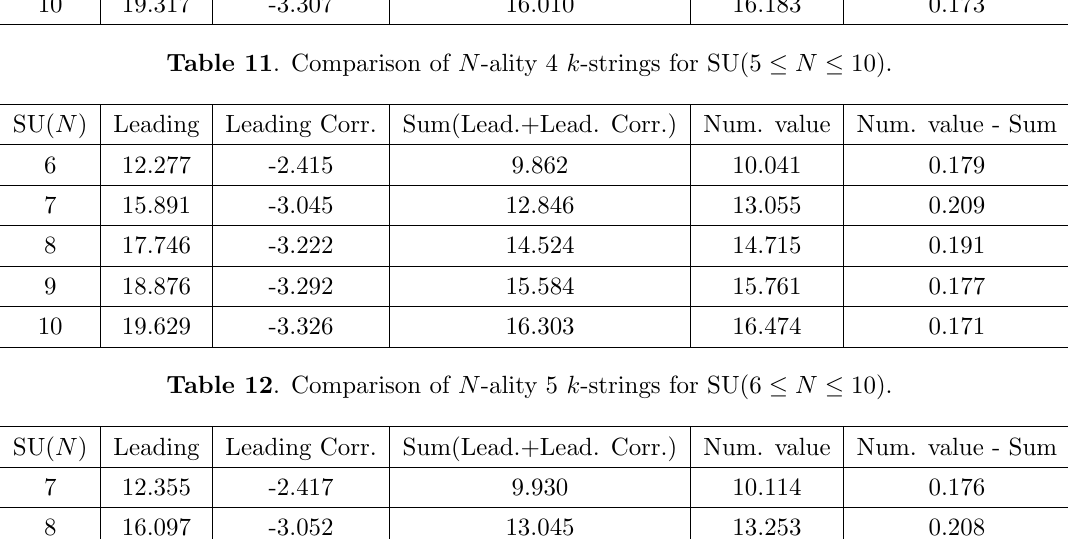
Table 11 . Comparison of N -ality 4 k -strings for SU(5